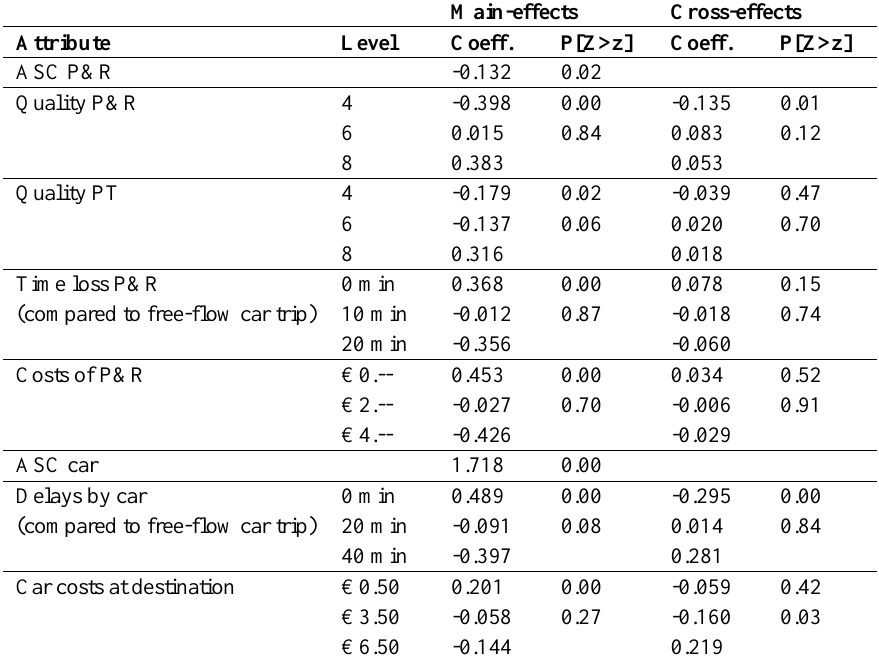
Table 4. Estimated main and cross-effects for the Netherlands as a